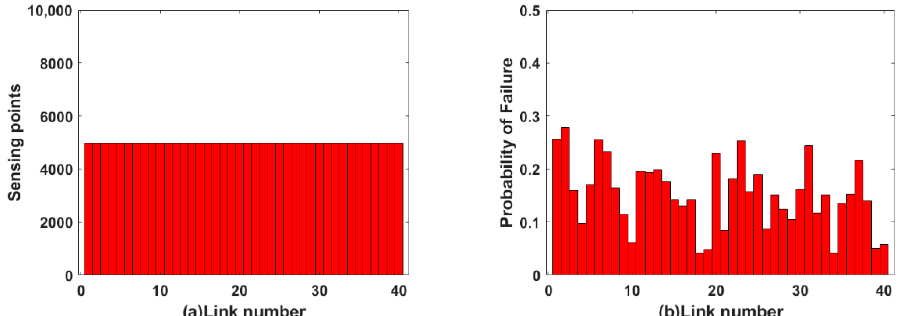
Figure 5. ( a ) The sensing points distribution in uniform allocation mode; ( b ) The distribution of link failure probability in uniform allocation mode.